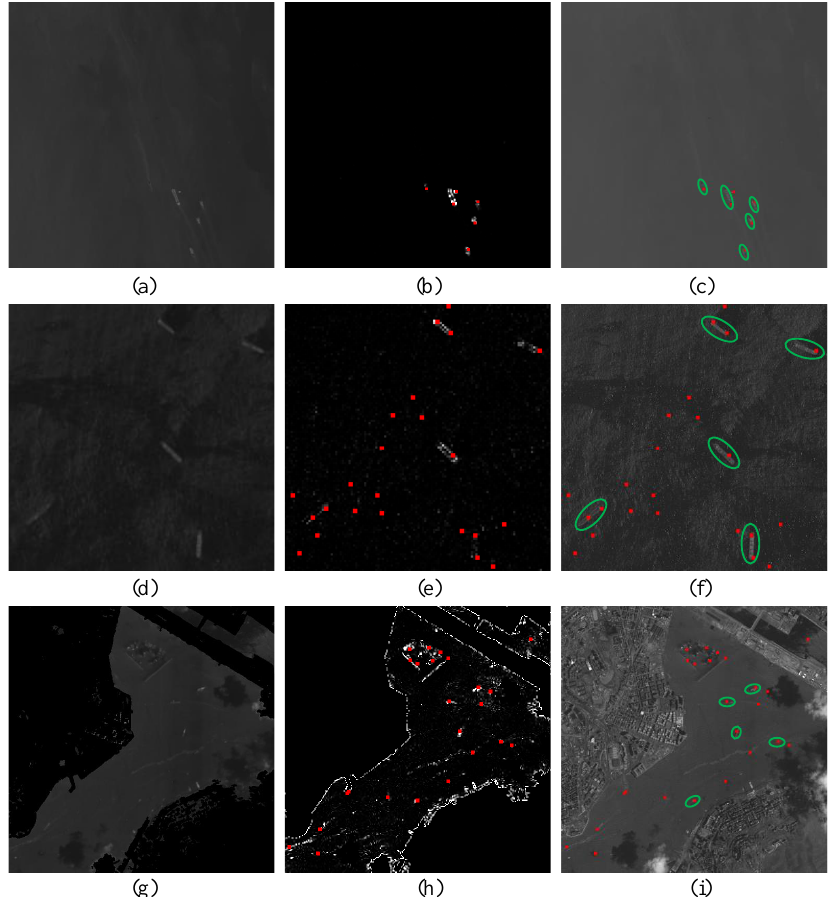
Figure 14. Ship location performance in different image backgrounds, including images with mist (first row), strong waves (second row), and complex backgrounds (third row). ( a , d , g ) are NIR images with land removed; ( b , e , h ) are the enhanced high frequency detail images; ( c , f , i ) are the localization of potential ship candidate regions on panchromatic